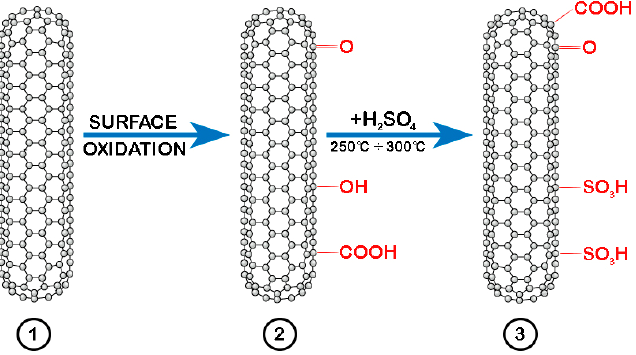
Figure 1. The schematic representation of sulfonated SWCNTs preparation process: 1 – SWCNTs purification; 2 – oxidation process; 3 – sulfonating operation.